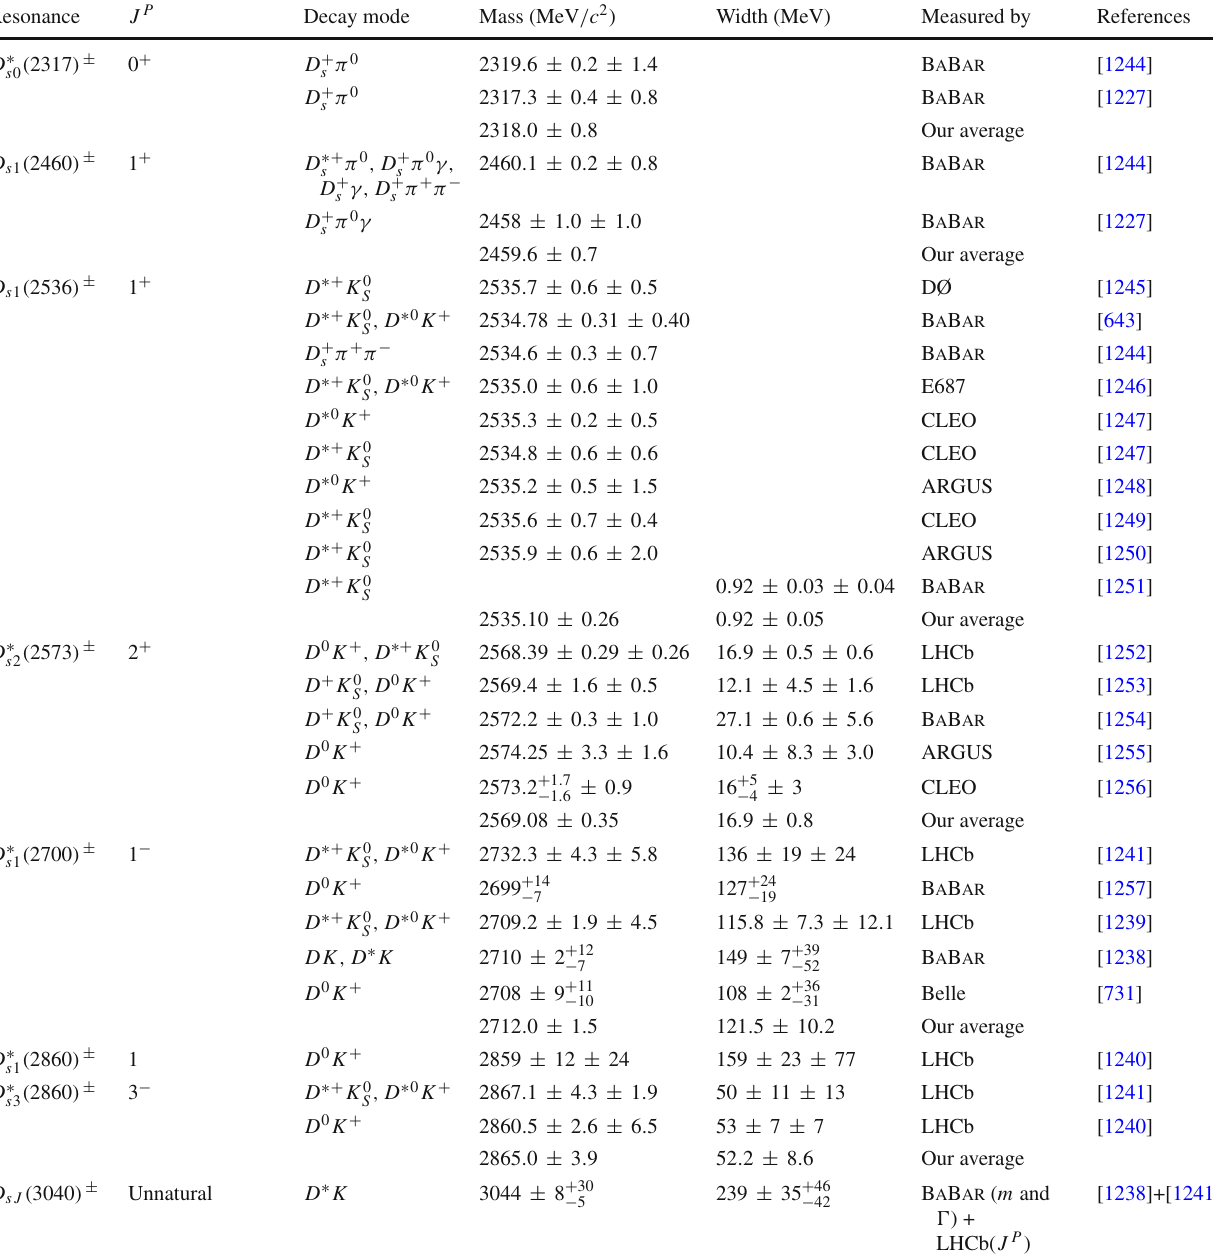
Table 289 Recent measurements of mass and width for different excited D s mesons. The column J P list the most significant assignment of spin and parity. If possible an average mass or width is calculated